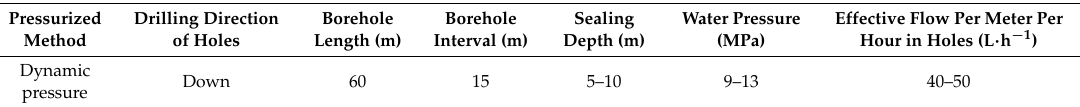
Table 8. Parameters of water injection of long borehole length on-site.